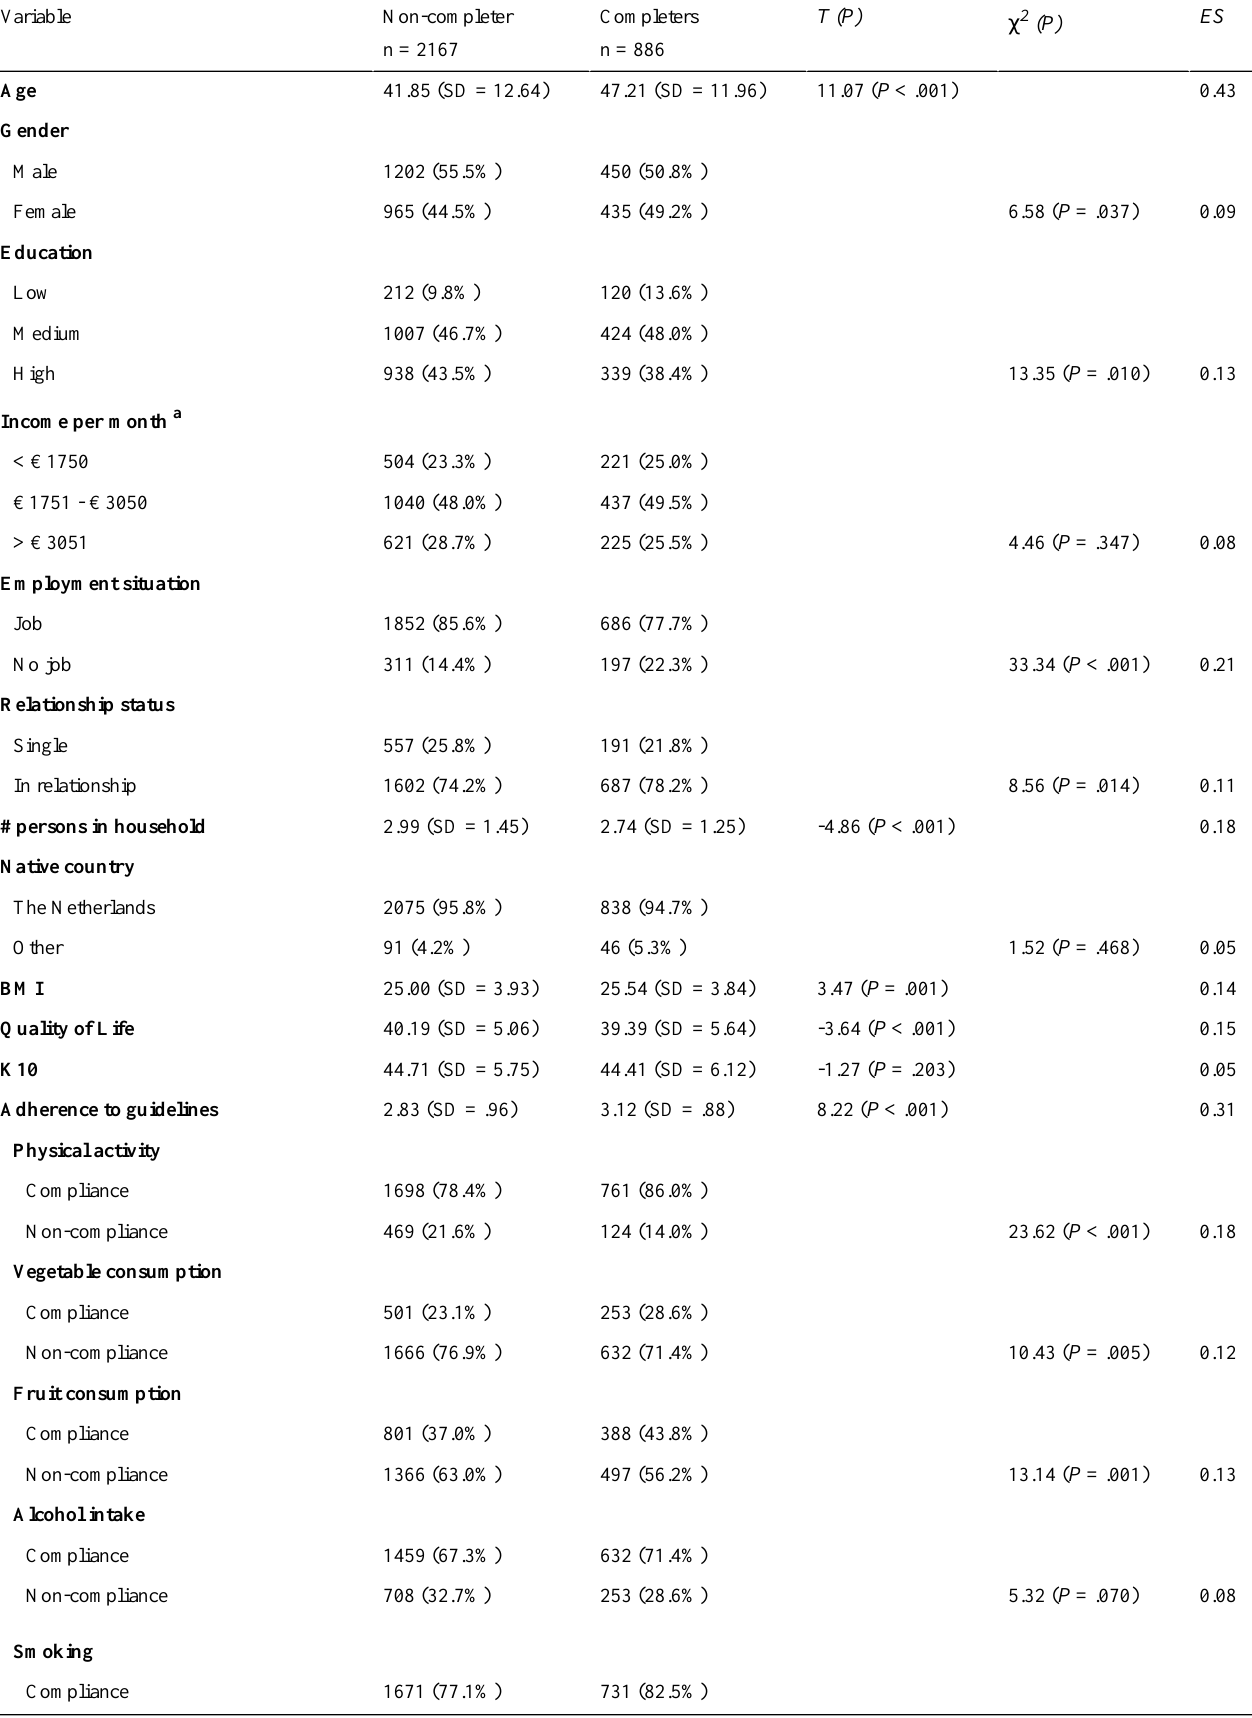
Table 2. Differences in demographics, health status and lifestyle between non-completers and completers (N =